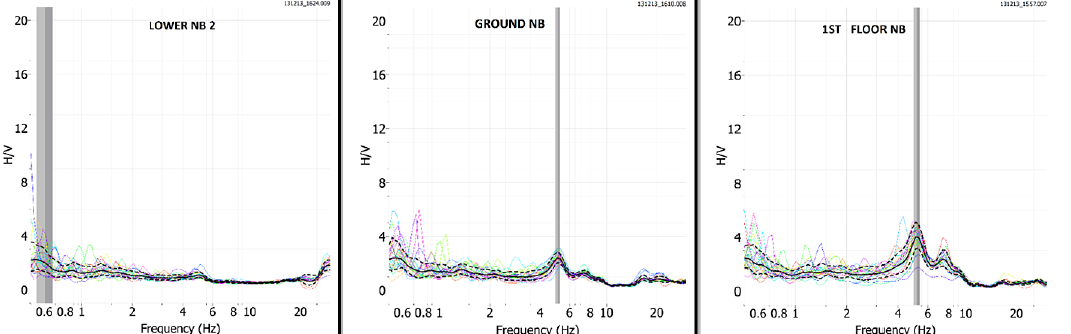
Figure 20. HVSR plots of acceleration recordings for lower floor new building (left figure), ground floor new building (middle figure) and first floor old building (right figure).